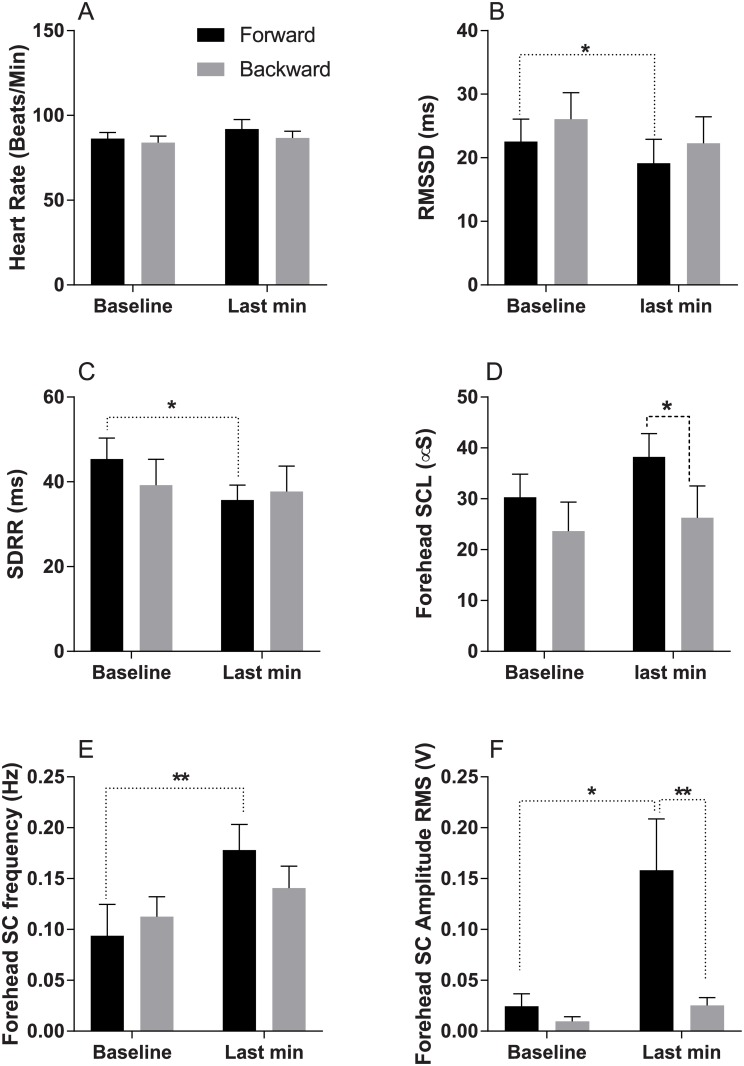
Changes in physiological parameters during forward (black bars) and backward (grey bars) virtual rides.Each graph shows data values for the last minute of baseline period and for the last minute of simulated ride. A—Heart rate; B—Root Mean Square of the Successive Differences in R-R intervals (RMSSD); C—Standard Deviation of RR interval (SDRR); D—Forehead tonic (DC) skin conductance; E—Forehead phasic skin conductance spike frequency; F—Forehead phasic (AC) skin conductance spike amplitude RMS. * and **—p<0.05 and p<0.01, respectively.